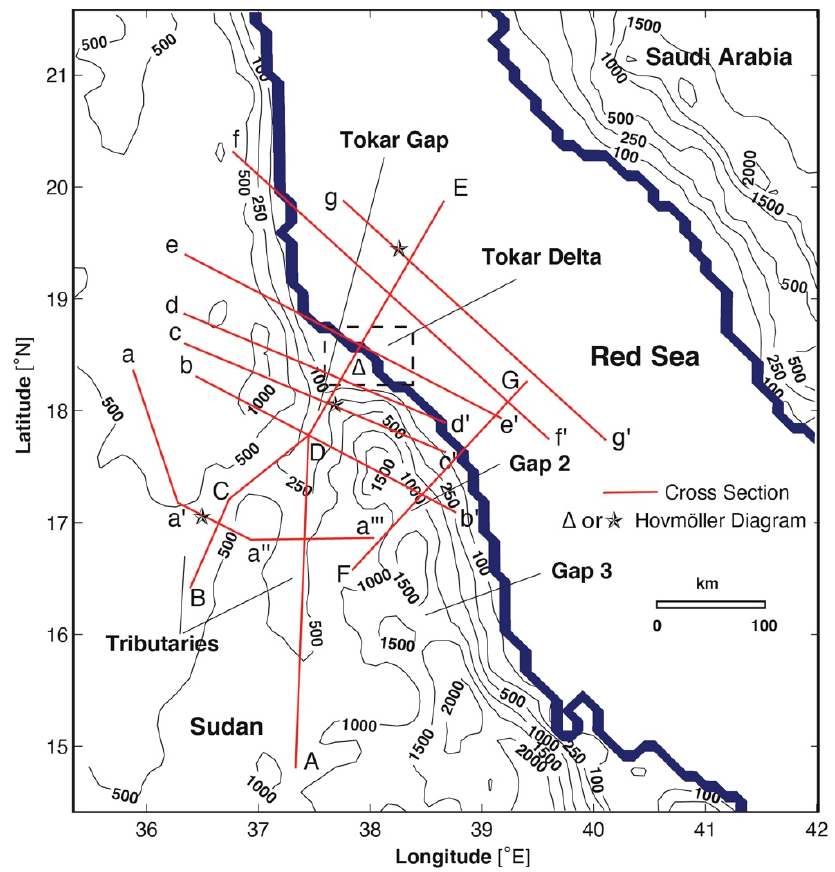
Figure 1. Regional map showing Red Sea Hills, Tokar Gap and Gaps 2 and 3 to the south. ‘Tributaries’ refer to the two entrance channels. The red lines show section locations, and the symbols indicate locations for Hovmöller diagrams, as cited in later figures. Topographic elevation contours are labeled in meters.